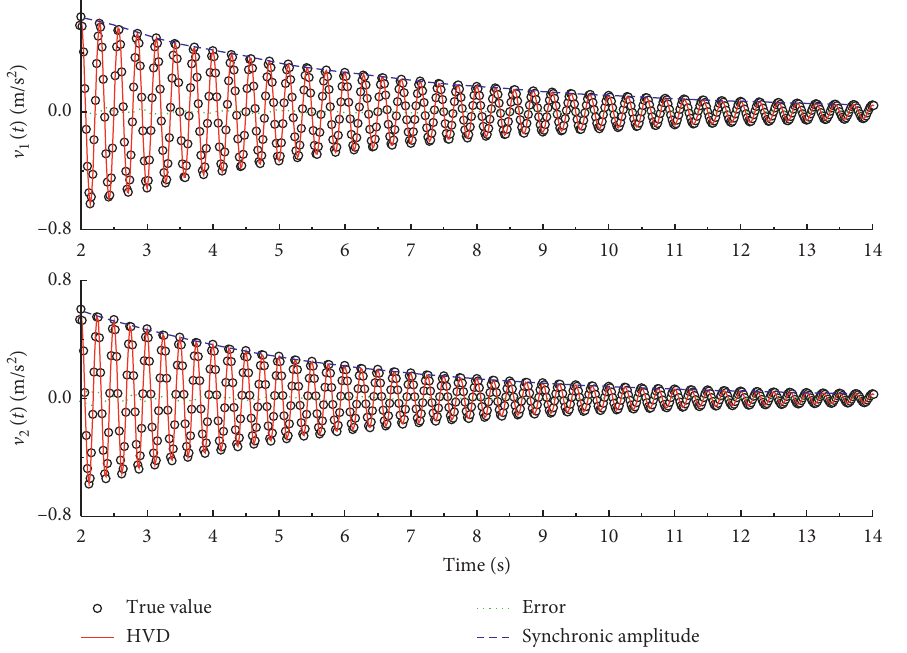
and v are the 1 2